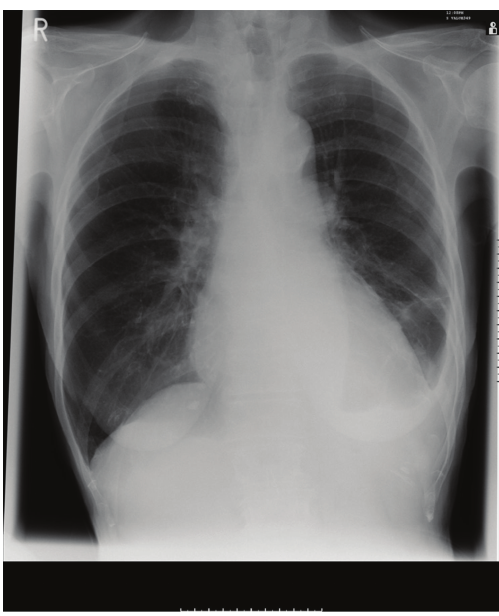
Figure 2: Resolution of pleural e ff usion after discontinuation of